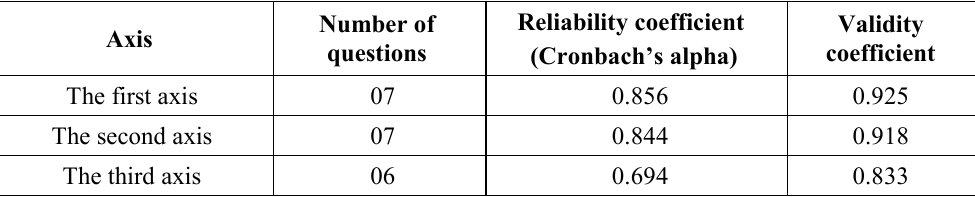
Table3. Results of Reliability